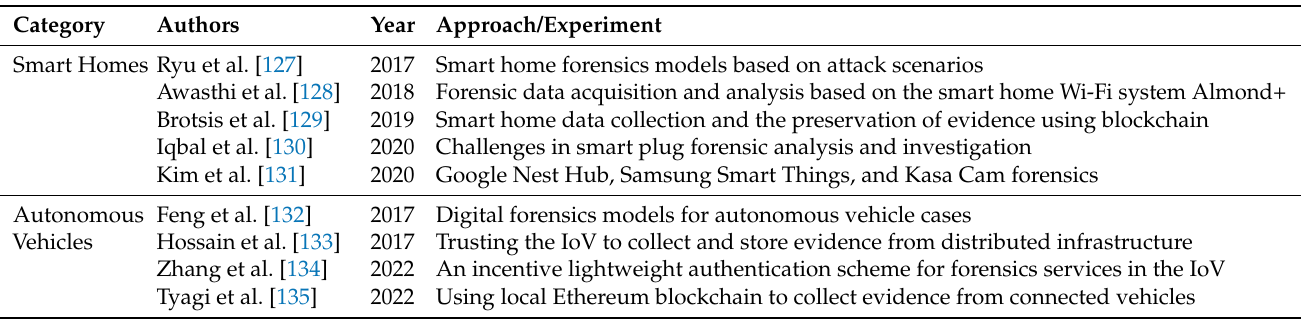
Table 4. A summary of the research on cyber forensics for smart homes and autonomous